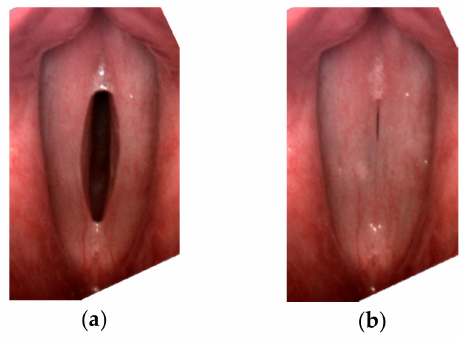
Figure 5. Images of the glottis for dysphonic patient D4 with minimal spindle-shaped glottal insuffi- ciency for the maximum opening ( a ) and maximum closing ( b ) of the vocal folds